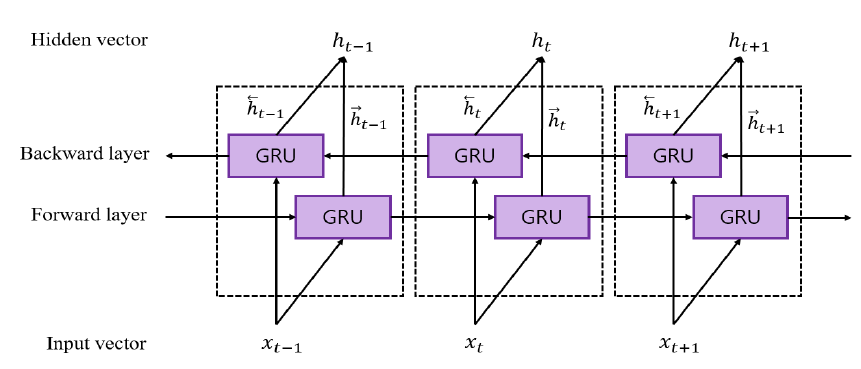
Figure 6. Bidirectional GRU